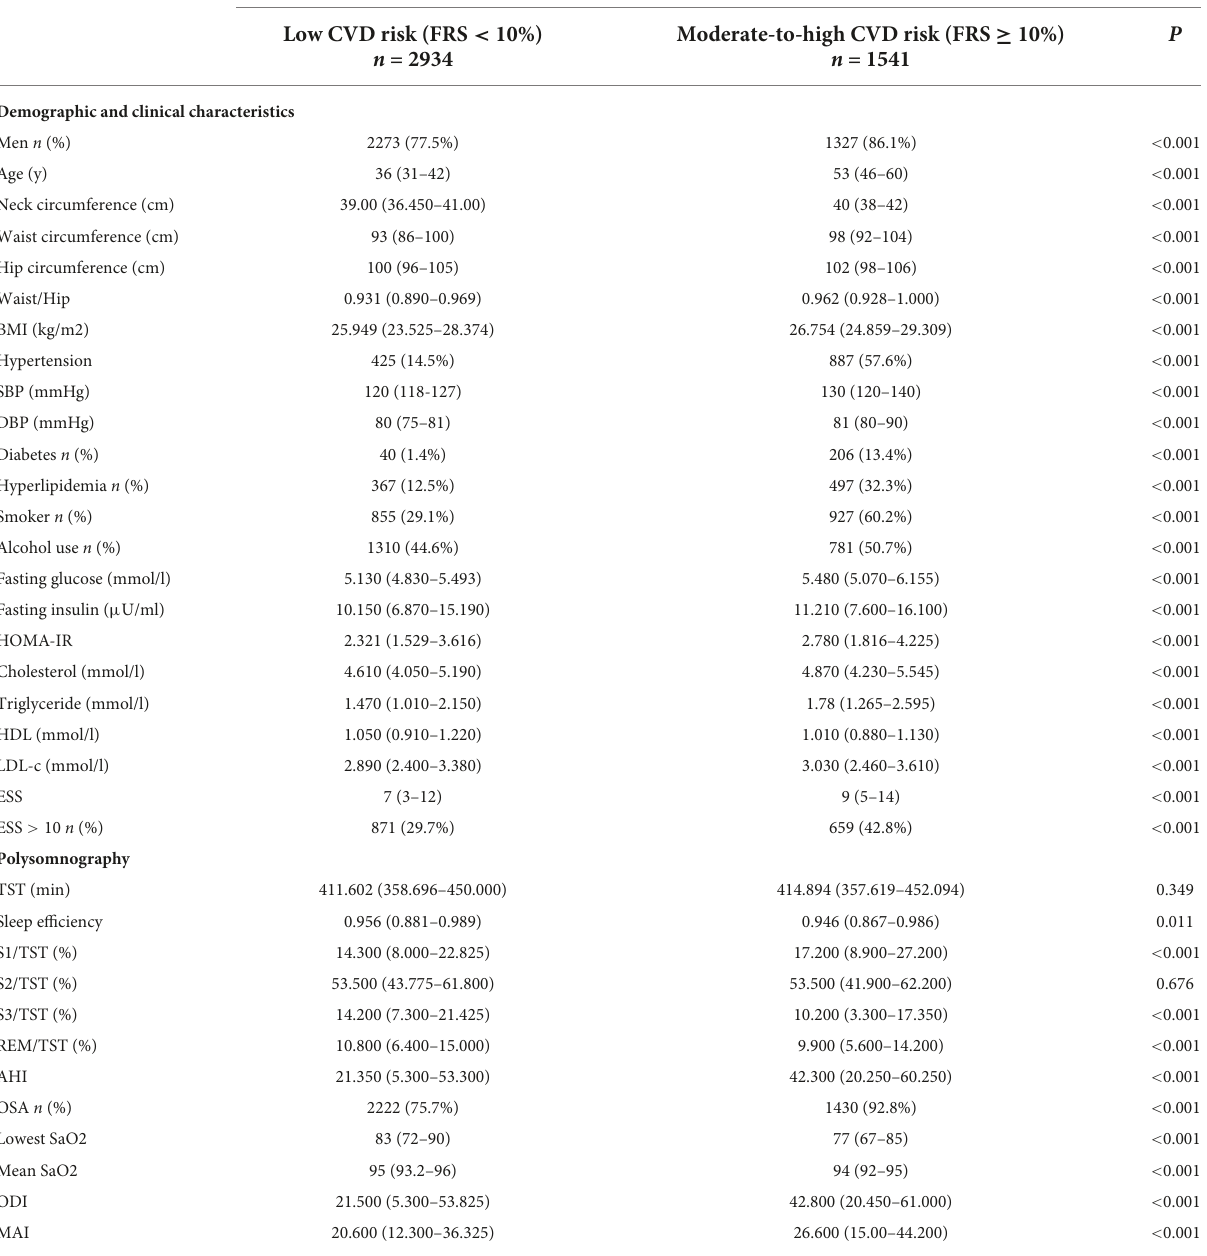
TABLE 1 The demographic, clinical, and sleep characteristics of the overall participants stratified by the FRS.